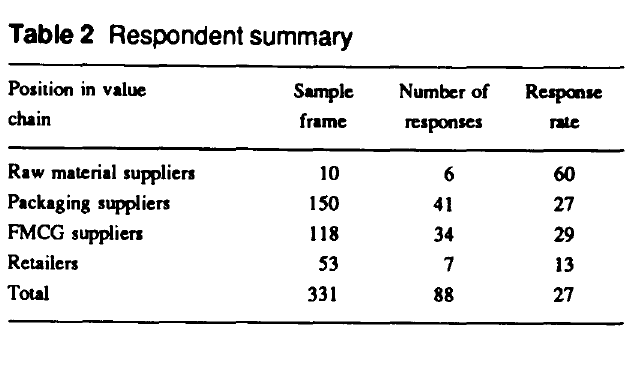
Table 2 Respondent summary